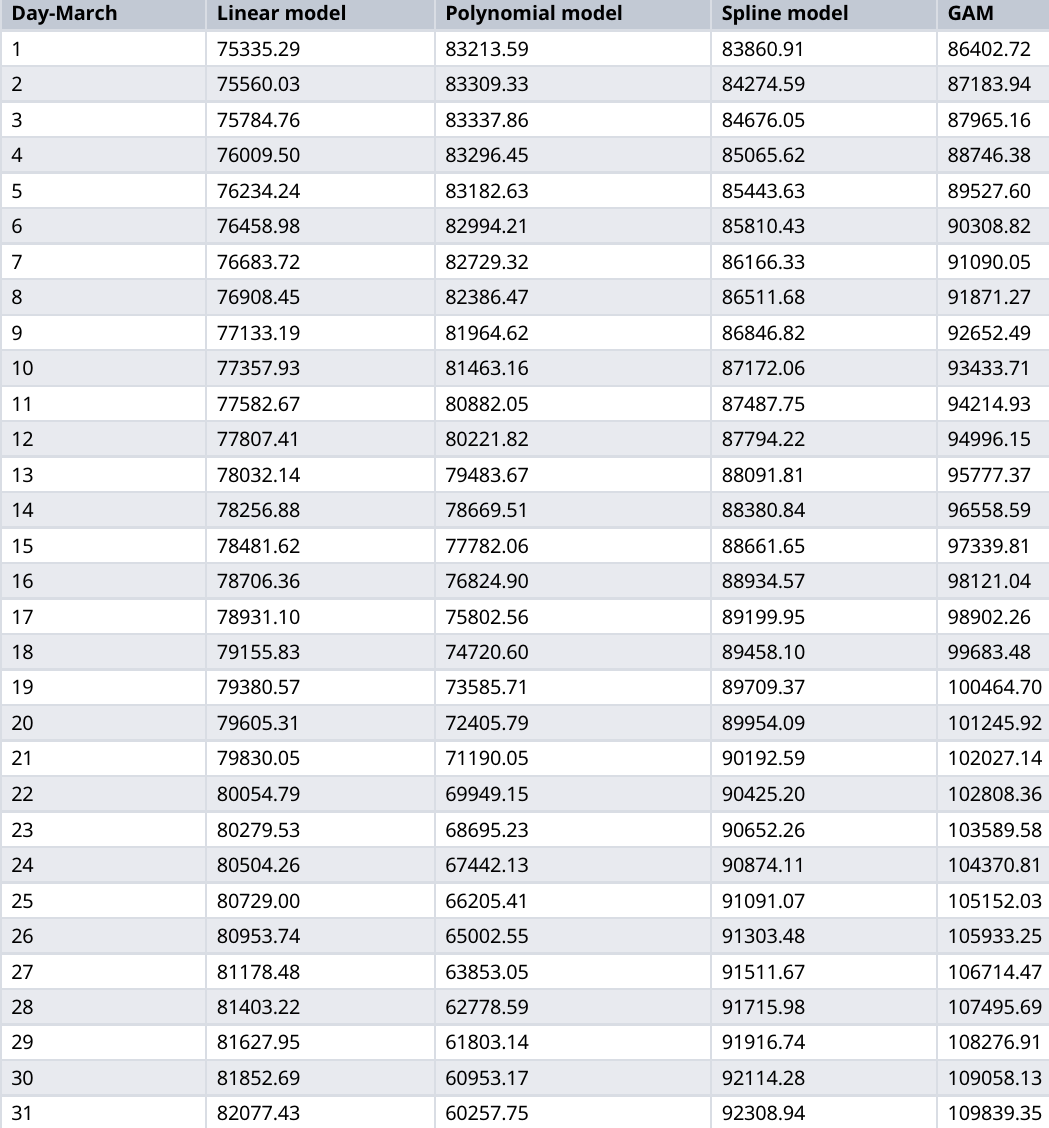
Table 2. Forecasts of cumulative COVID-19 cases from March 1 to March 31,